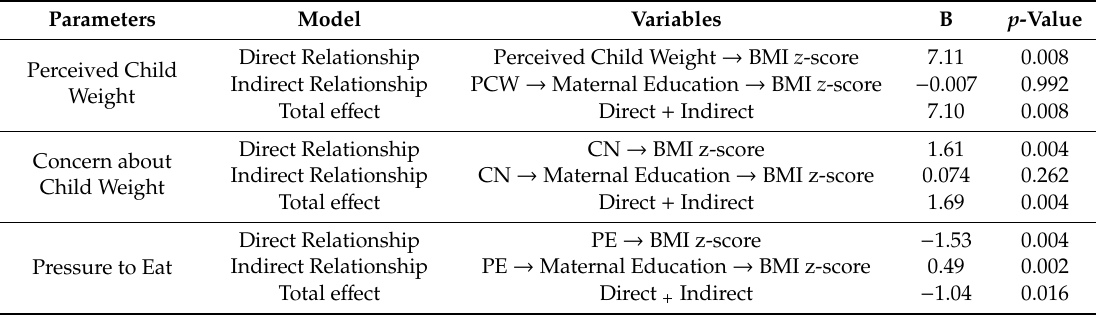
Figure 2. Path model showing the direct and indirect relation of the Perceived Child Weight, Parental Concern, and Pressure to Eat factors with BMI z-score through maternal education. Significant levels are ** p < 0.01 and *** p < 0.0001. Table 6. Perceived Child Weight, Concern about Child Weight, and Pressure to Eat Related to BMI z-score through Maternal Education.